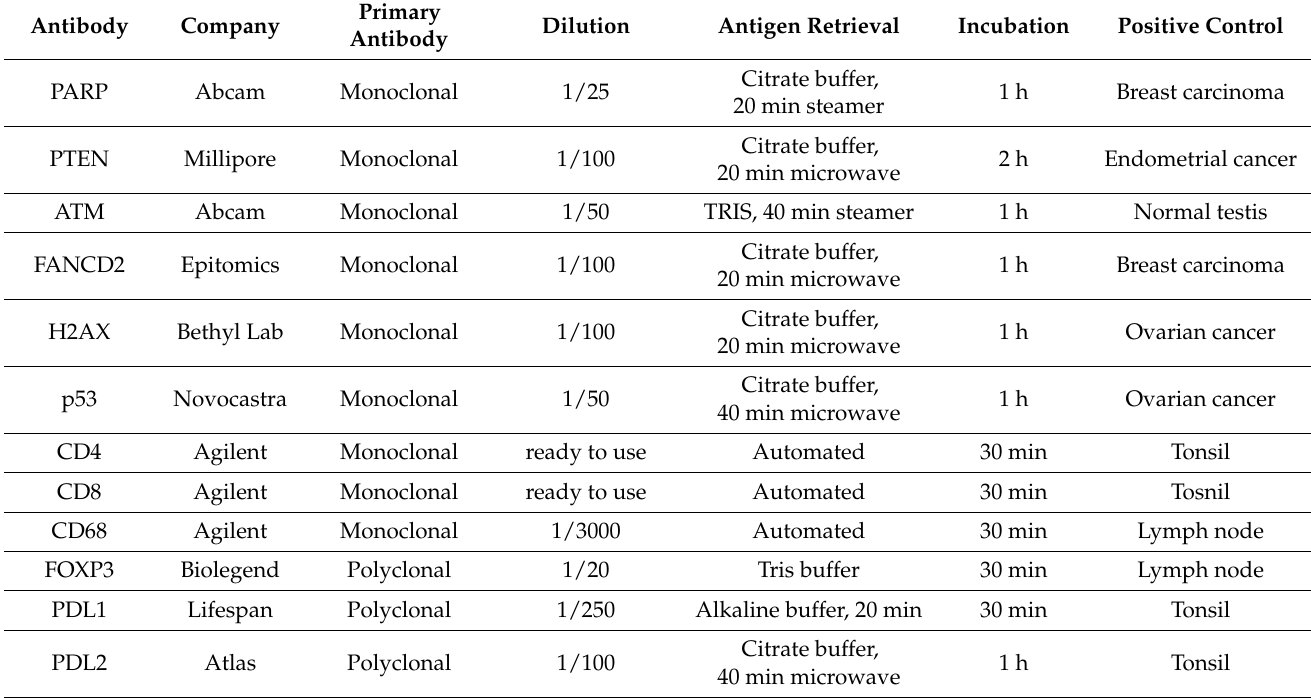
Table 1. Immunohistochemistry